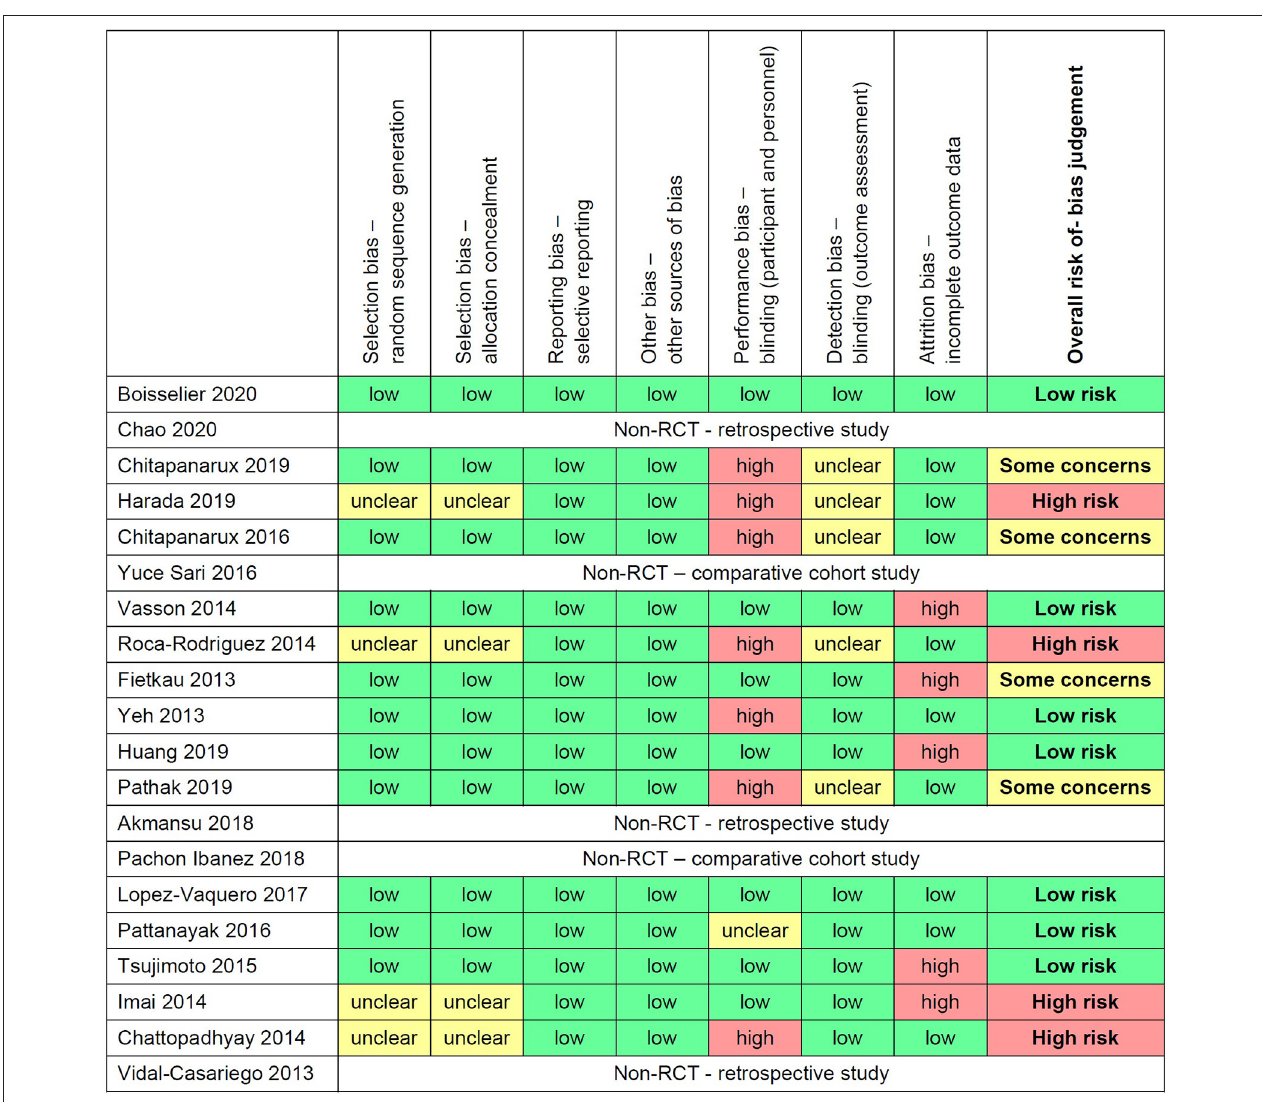
FIGURE 2 | Summary of risk of bias assessment using the Cochrane Risk of Bias Tool for Randomized Control Trails.